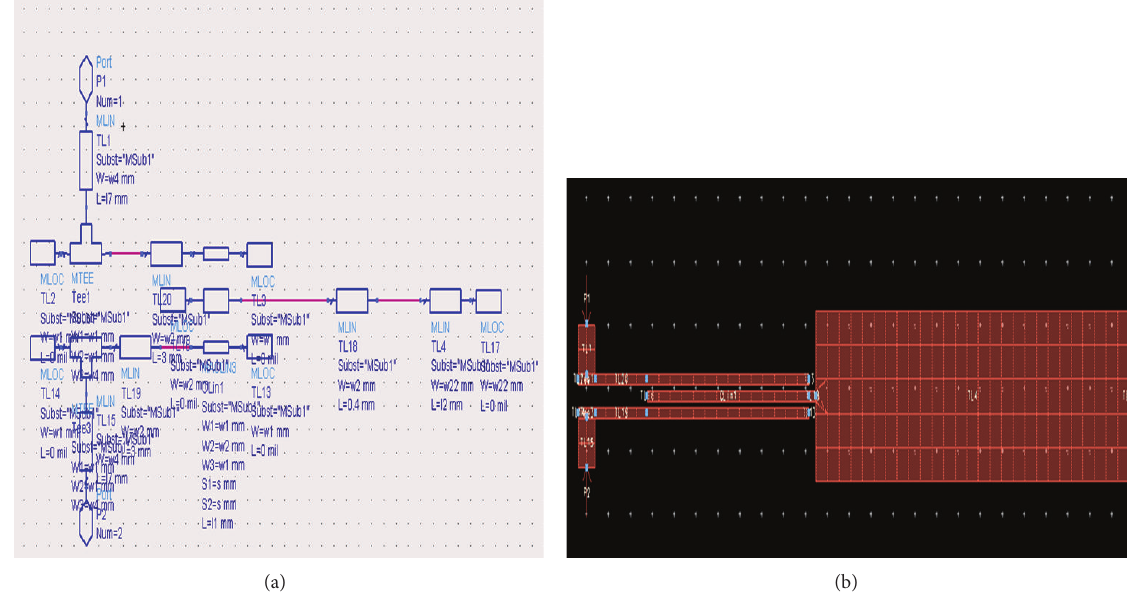
Figure 15: Structure of the broadband band-pass filter of [2] in the workspace of ADS.